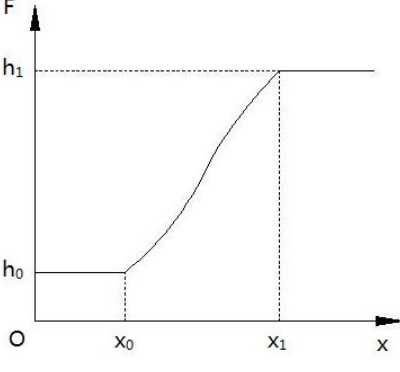
Figure 8. STEP function curve.